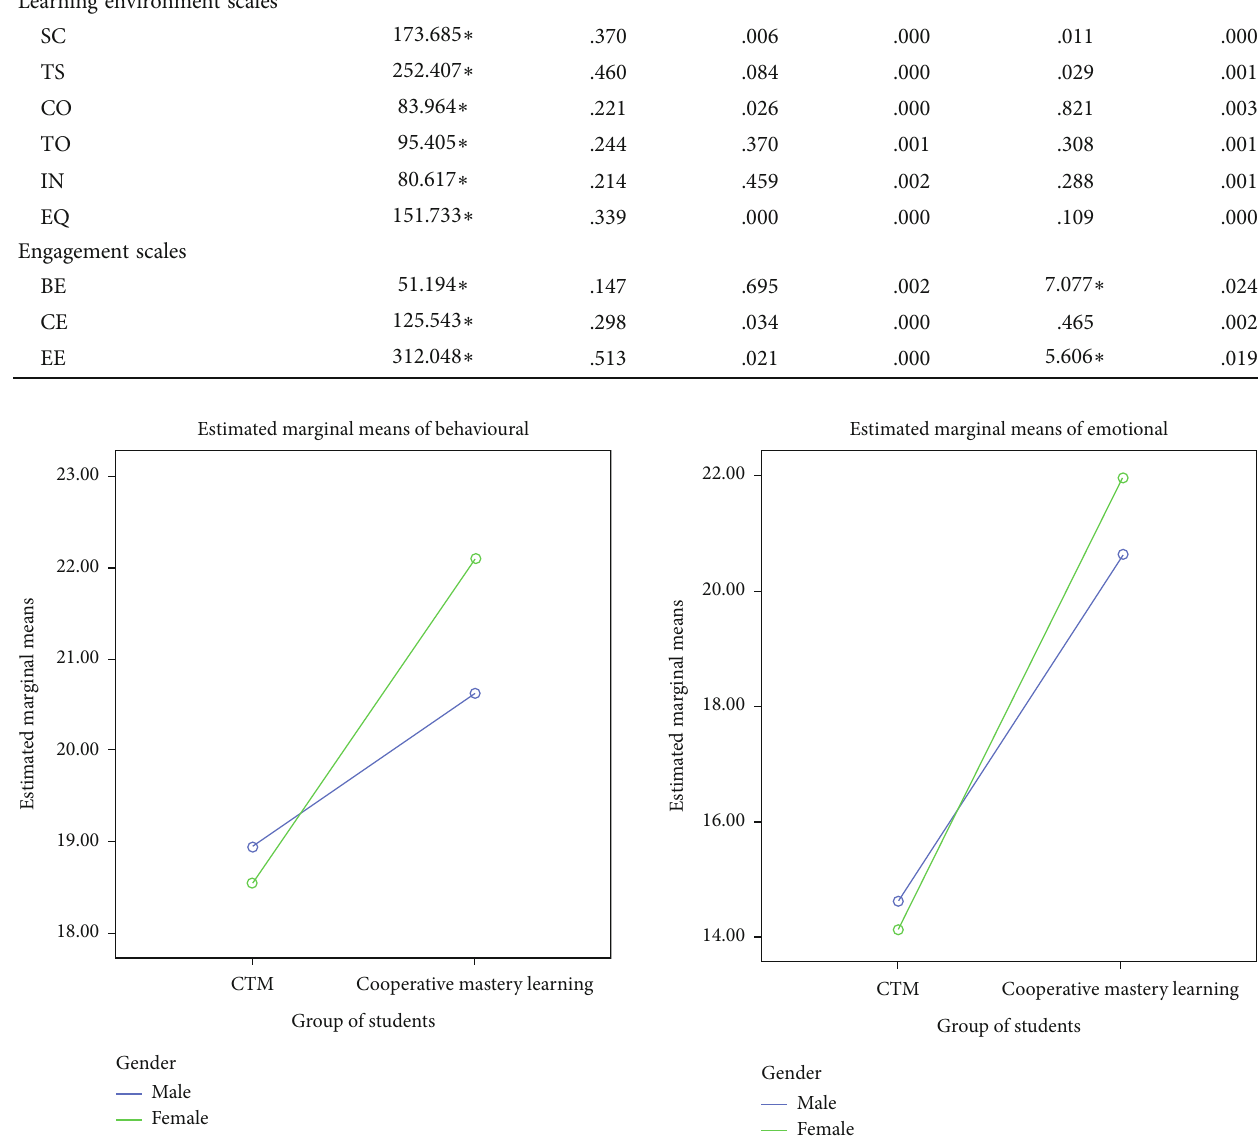
Figure 3: Interactions between treatment and sex for behavioural engagement.